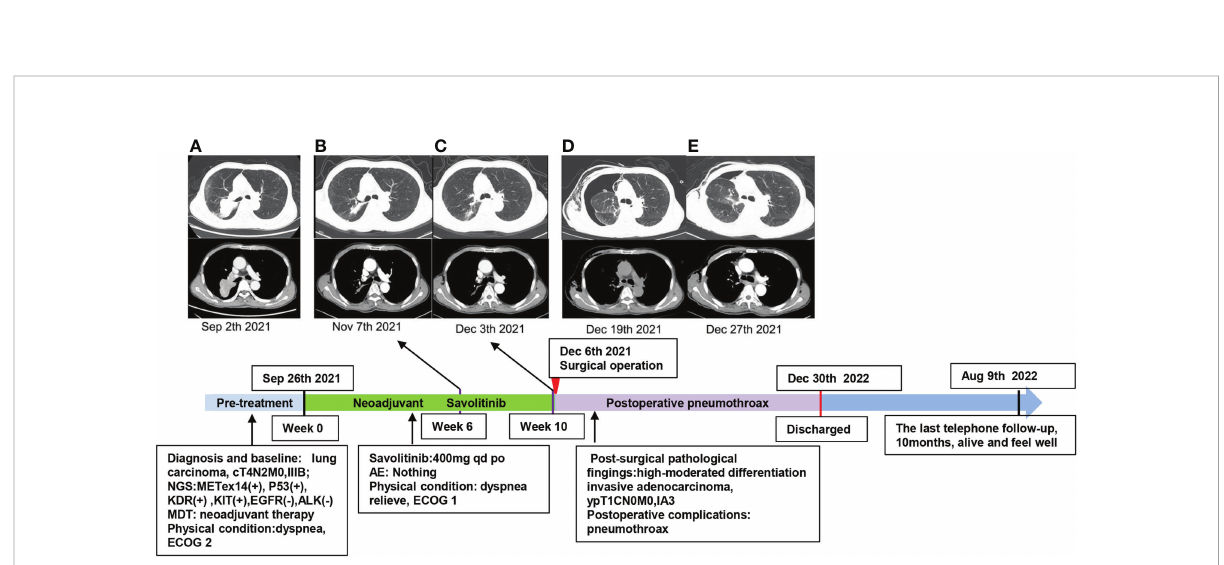
FIGURE 3 Timeline of the diagnosis and chest CT scans during the treatment and follow-up of this case. (A) Baseline imaging. (B) Treatment with savolitinib for 6 weeks. (C) Treatment with savolitinib for 10 weeks. (D) After 2 weeks of surgical operation, the patient had dyspnea, chest CT con fi rmed pneumothorax in the right lung, and closed thoracic drainage was performed on the patient. (E) Enhanced chest CT scans con fi rmed that the pneumothorax was improved 1 week later. The patient was alive and felt well at the last telephone follow-up on 9 August